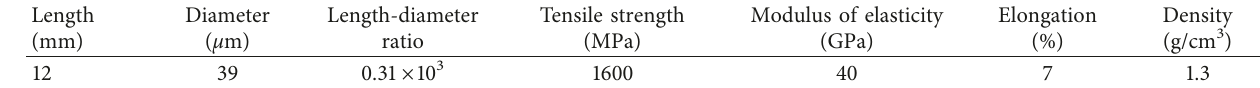
Table 1: Properties of PVA fiber.